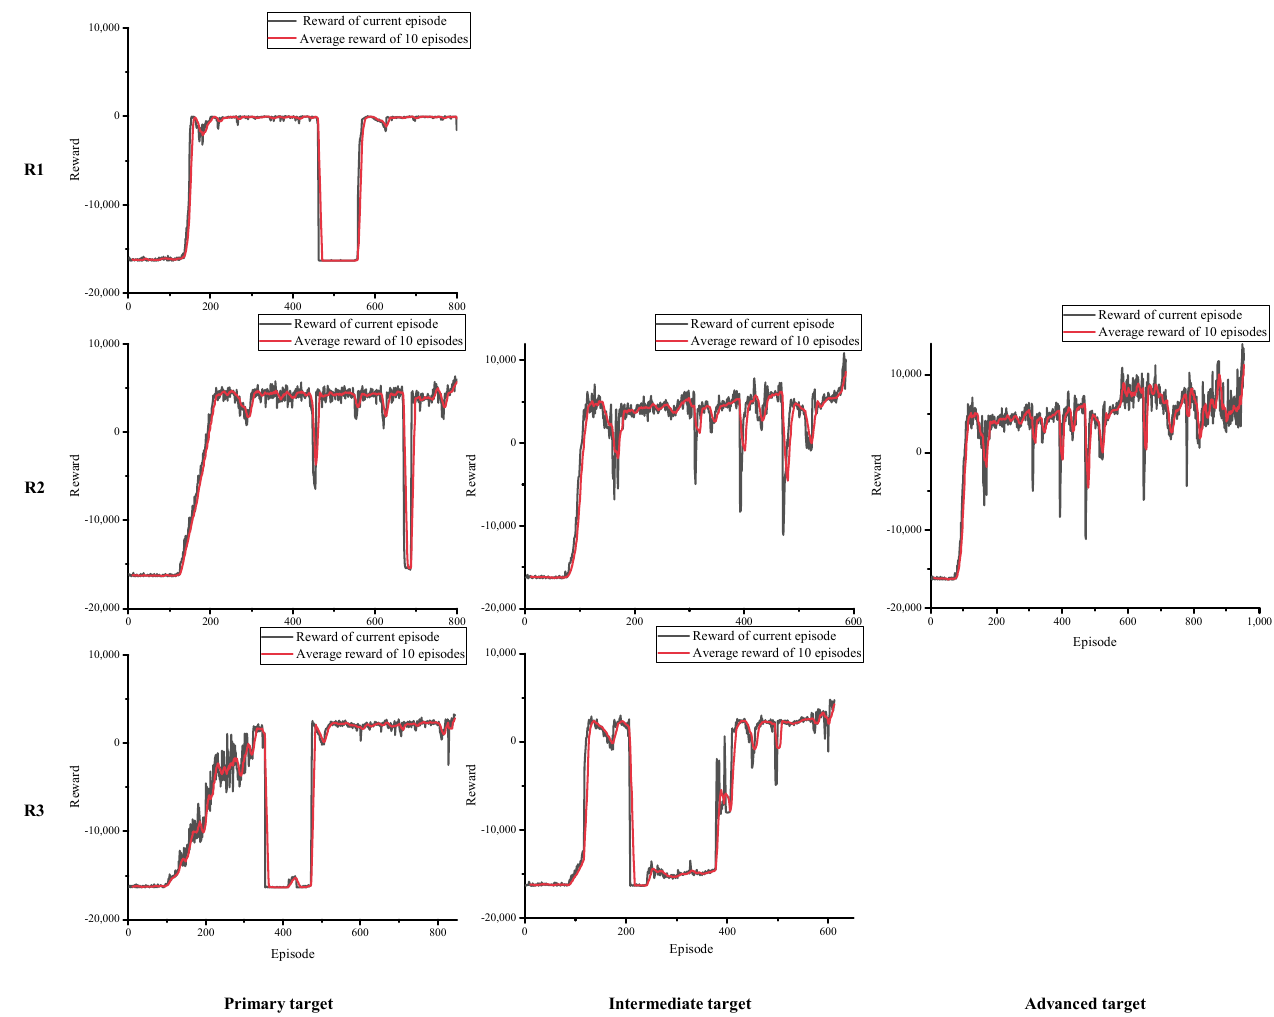
Figure 11. Training results of the three proposed reward functions.